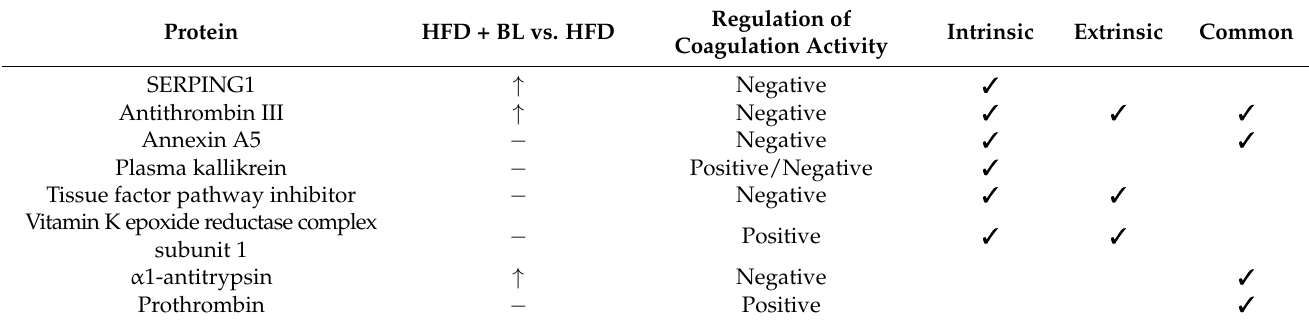
Figure 2. The top five signaling pathways affected by BL in the liver of HFD-fed mice. The downreg- ulated or upregulated proteins were shown in green and red bars. The overlap numbers show how many altered proteins were in specific pathways. Abbreviations: EIF2, eukaryotic initiation factor 2; eIF4, eukaryotic translation initiation factor 4; mTOR, mammalian target of rapamycin; p70S6K, 70-kDa ribosomal protein S6 kinase. Table 1. Effect of bromelain on the expression of proteins involved in the intrinsic, extrinsic, and common pathways in the liver of HFD − fed